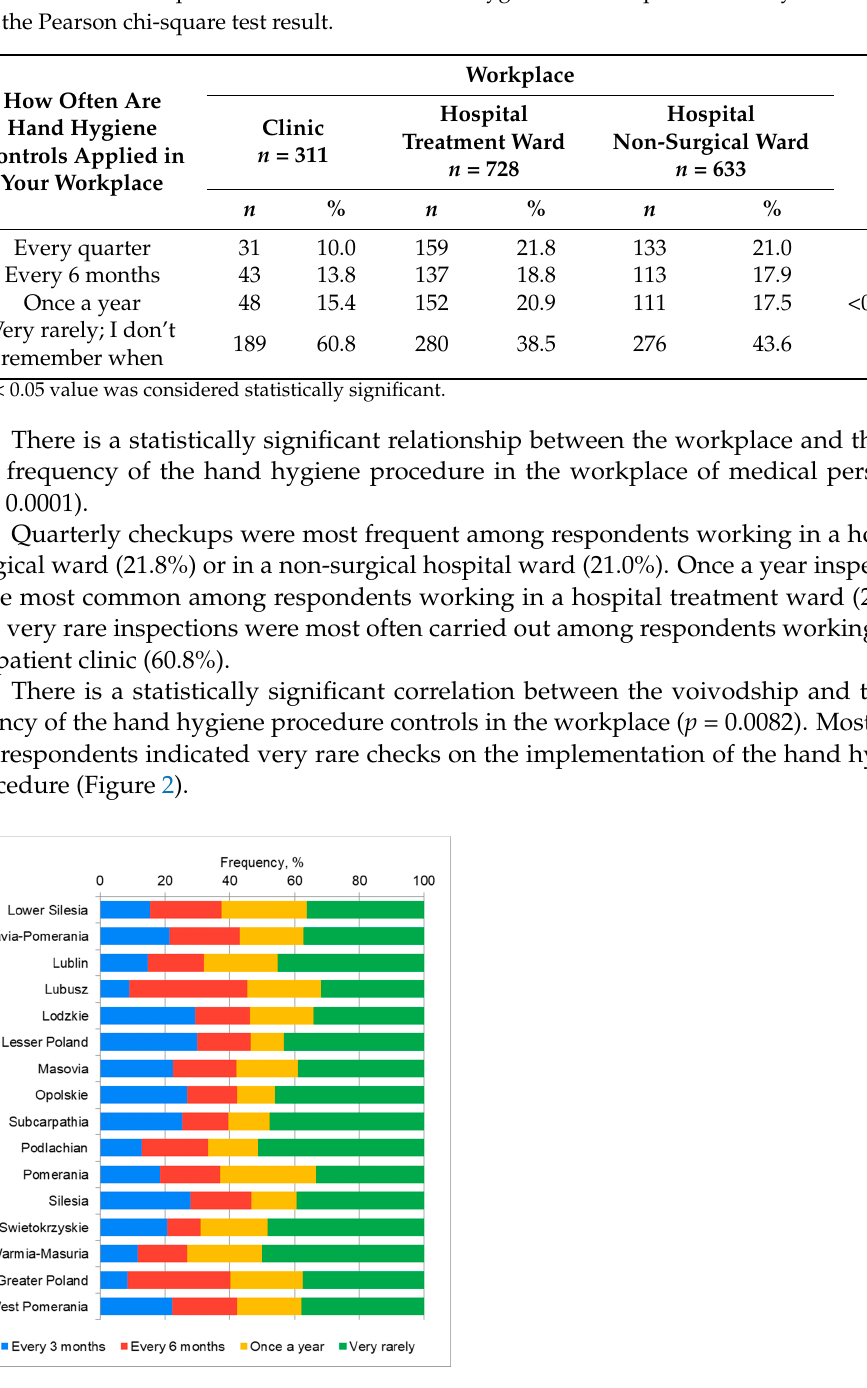
Figure 2. The frequency of inspections of the implementation of the hand hygiene procedure in the workplace in individual